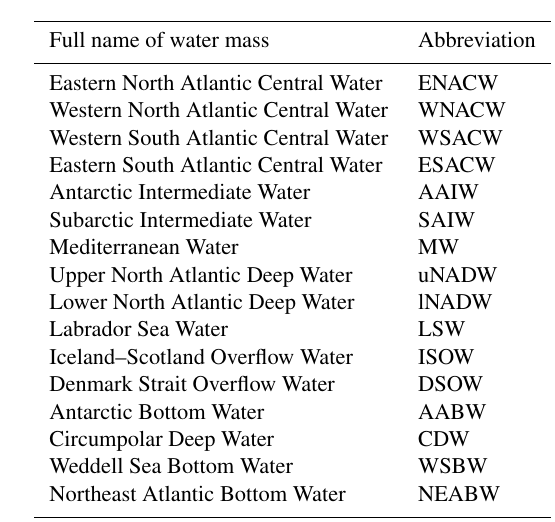
Table 3. The full names of the water masses discussed in this study, and the